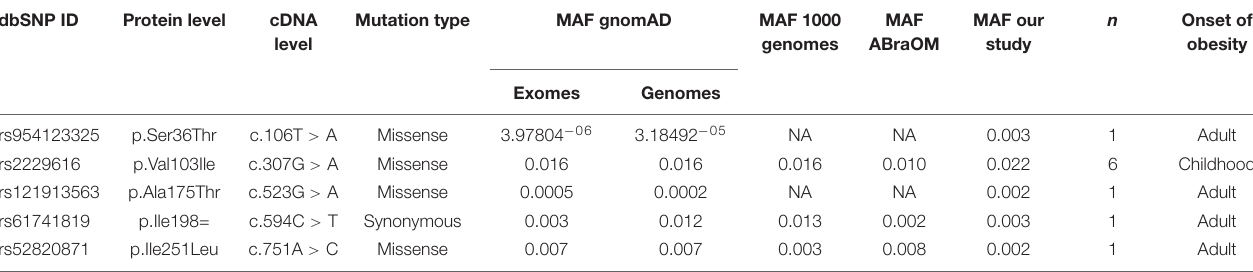
TABLE 2 | Variants identified in the MC4R screening in Brazilian cohort.